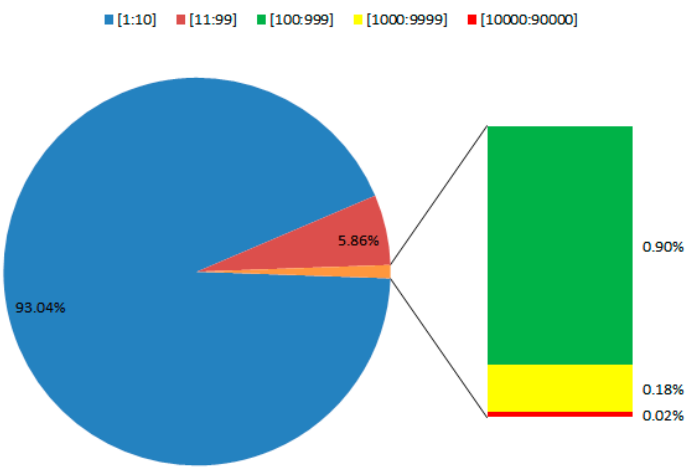
Figure 5. Proportions of POI affected areas with different numbers of POIs.